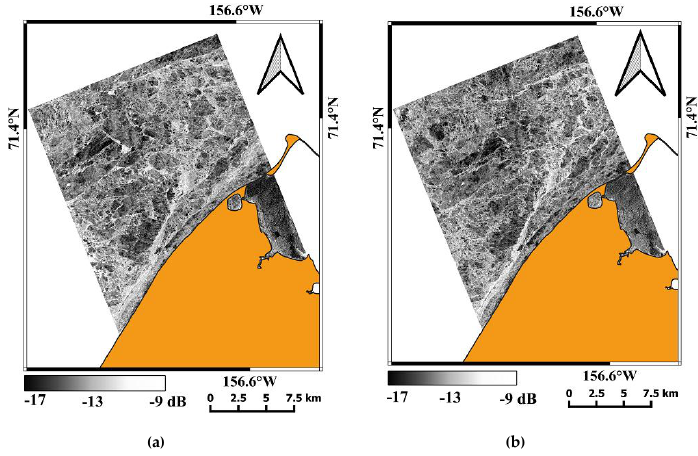
β ◦ , on 13 of Jan ( a ) 24 Jan ( b ). Land is masked out in Figure 5. Radar brightness, 𝛽 ° , on 13 of Jan ( a ) 24 Jan ( b ). Land is masked out in orange. Figure 5. Radar brightness,